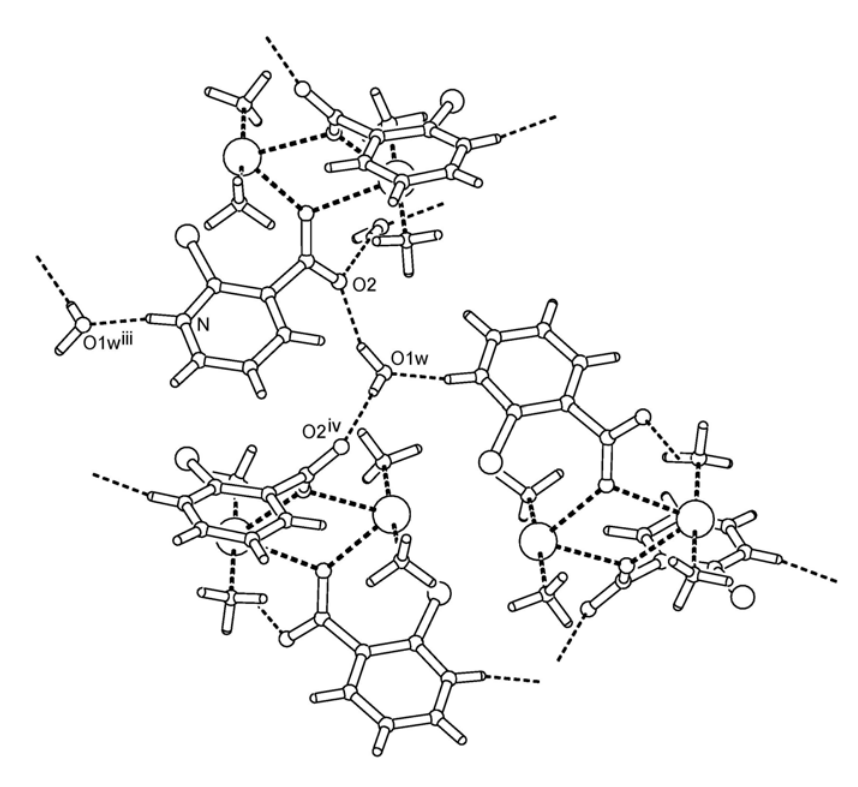
Fig. 2 PLATON diagram of the hydrogen bonds in [TlMe 2 (2mna)] · H 2